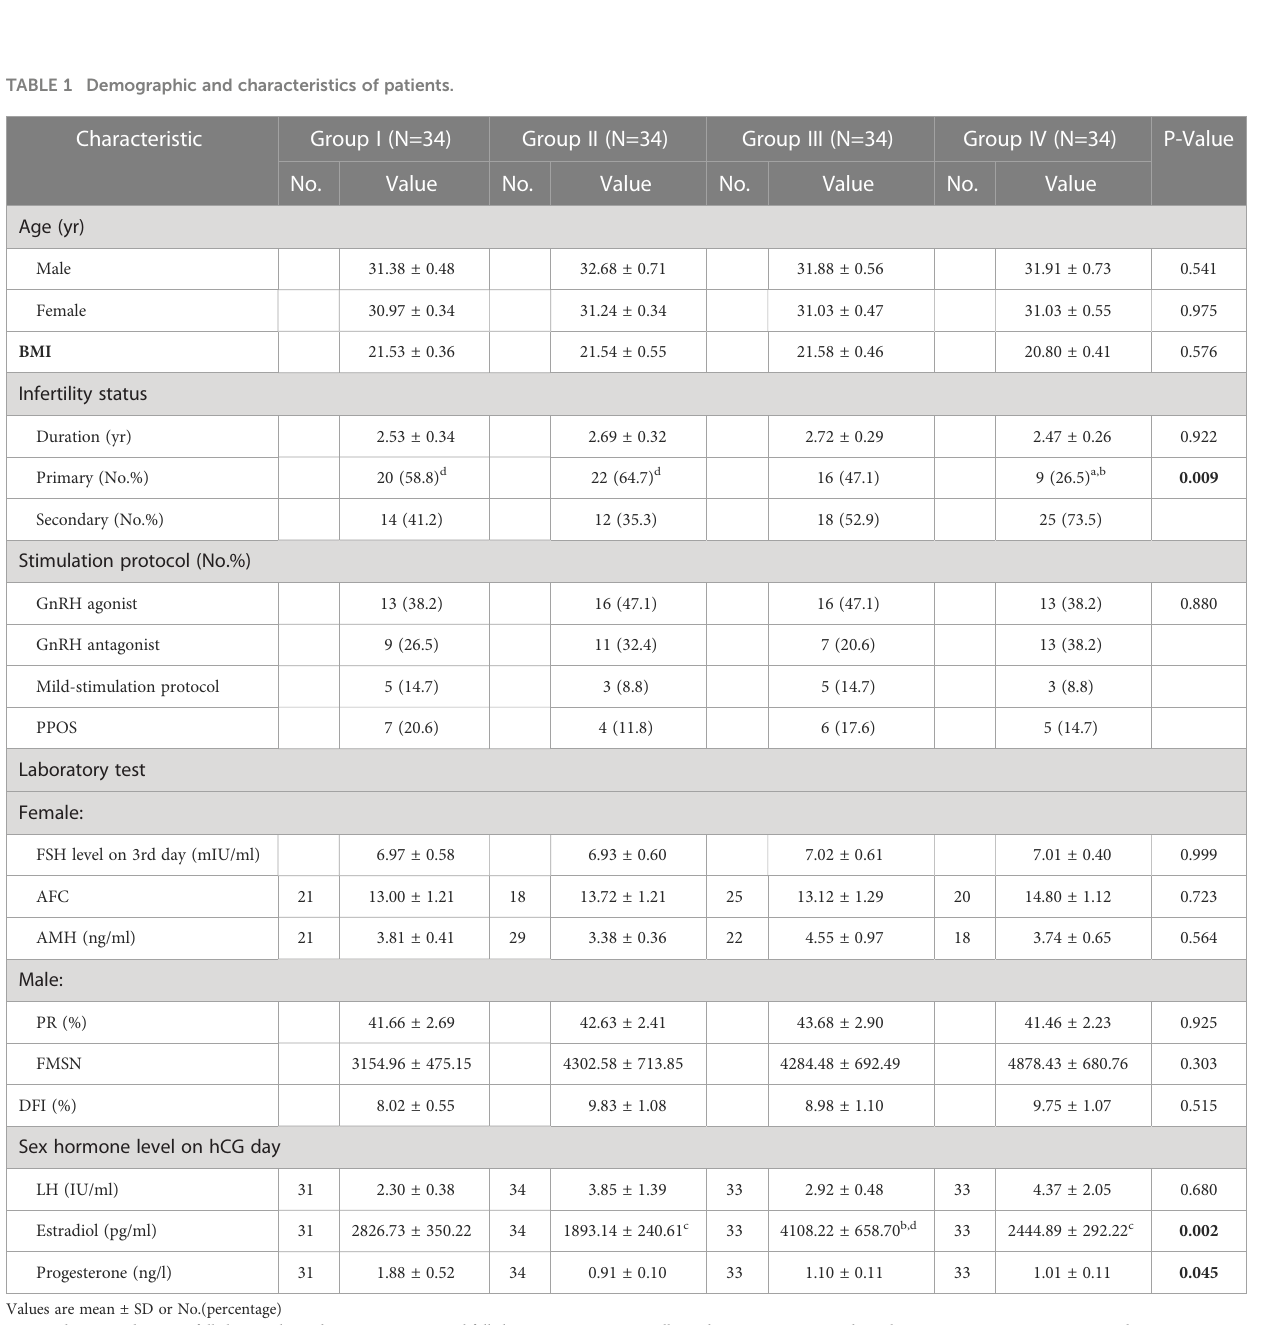
Table 2. The FR had lower signi fi cant differences in Groups I and II than in Groups III and IV (71.7% and 70.3% for Groups I and II vs 83.5% and 80.4% for Groups III and IV, P = 0.000). The GQER in Group I to Group IV was 32.7%, 37.4%, 26.5%, and 33.3%, respectively ( P = 0.056) (Table 2).